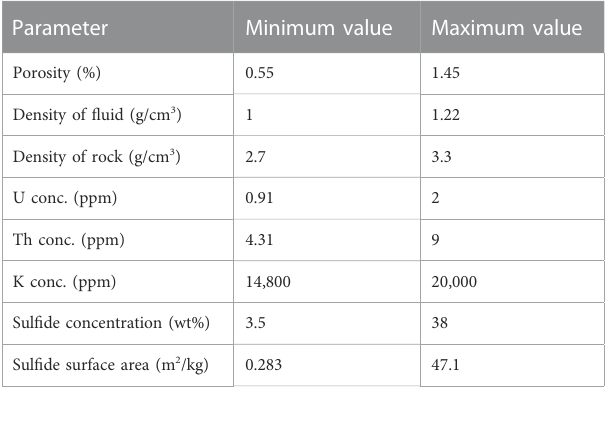
TABLE 1 Range of values for Kidd Creek Observatory used in this Monte Carlo- based approach based on published values, as described in full in the main